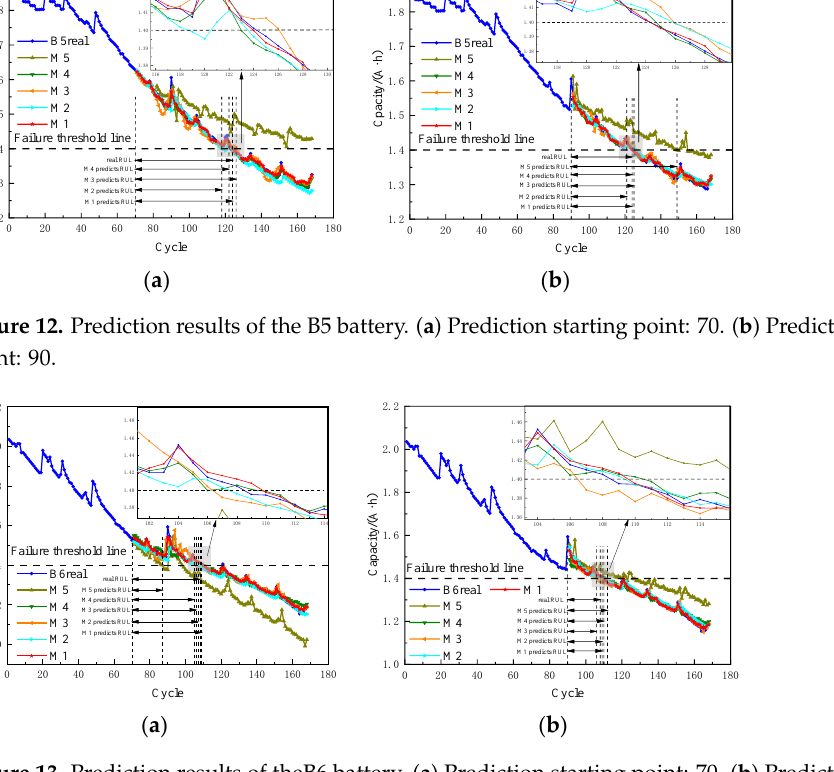
Figure 13. Prediction results of theB6 battery. ( a ) Prediction starting point: 70. ( b ) Prediction starting point: 90.